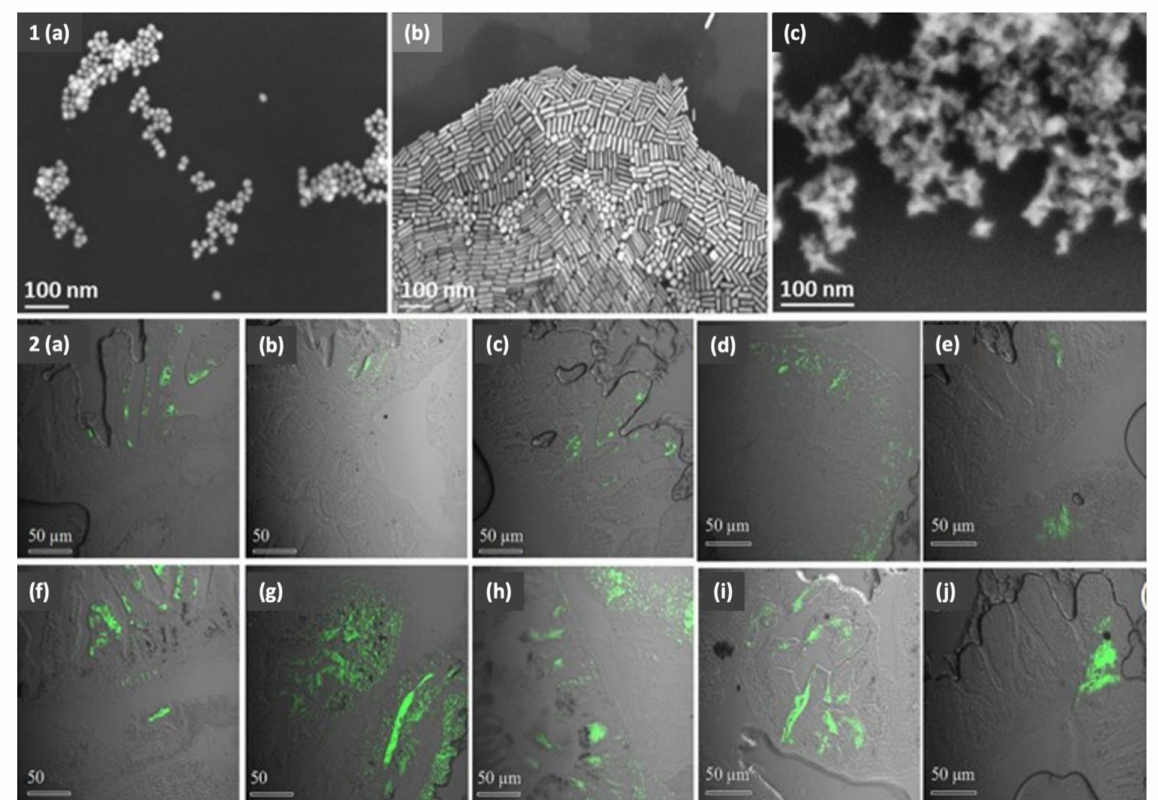
Figure 5. SEM images ( 1 ) of different shapes of Au NPs. Namely, spherical Au NPs ( a ), rod Au NPs ( b ), and star Au NPs ( c ). Confocal images ( 2 ) of zebrafish digestive system after injection with Fluorescein-conjugated glyco-Au NPs after different time points. Namely, spherical Au NPs after 4 h ( a , f ) (with slightly different sizes); rod Au NPs after 4 h ( b , g ) (with slightly different sizes), 24 h ( d ), and 48 h ( e ); and star Au NPs after 4 h ( c , h ) (with slightly different sizes), 24 h ( i ), and 48 h ( j ). Reproduced from [81] under the terms of the Creative Commons Attribution 4.0 License with modifications; Springer Nature Limited,